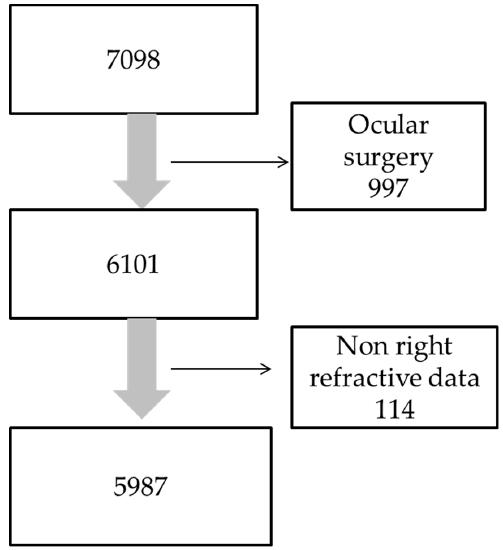
Figure 1. Study flow chart of this study. The number of participants who were 40 years old and over was 7098. Of them, 5987 participants were defined as the subjects after excluding 997 participants who had a history of ocular surgery and 114 participants who did not have refractive indices of their right eye.